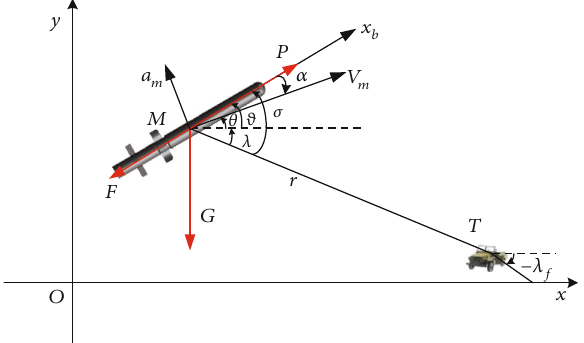
Figure 1: Geometric diagram of relative motion between